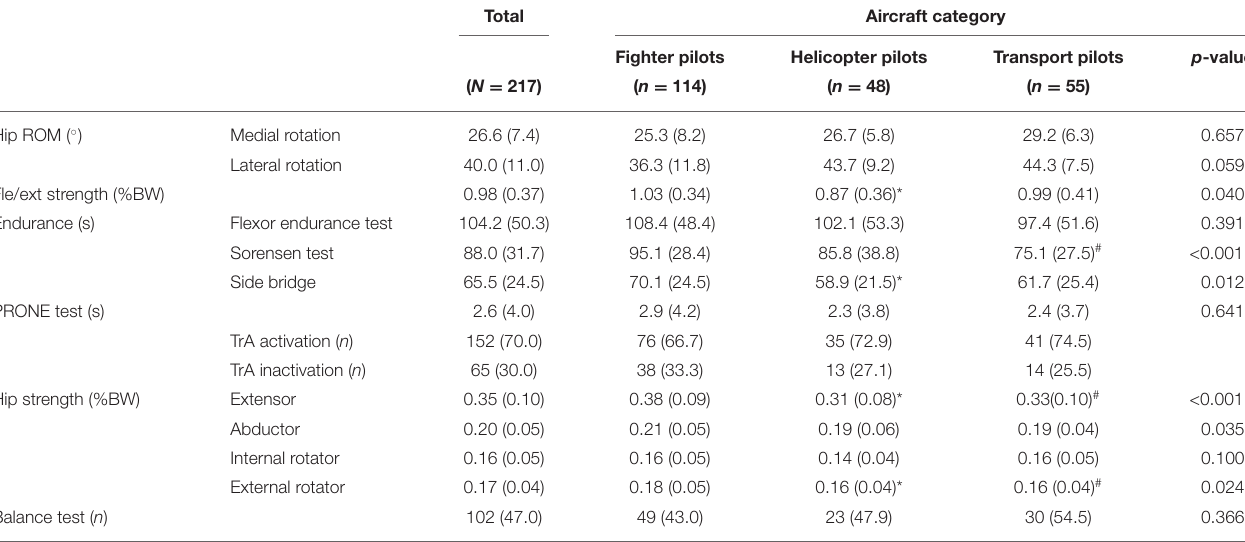
TABLE 2 | Physical functions in the study